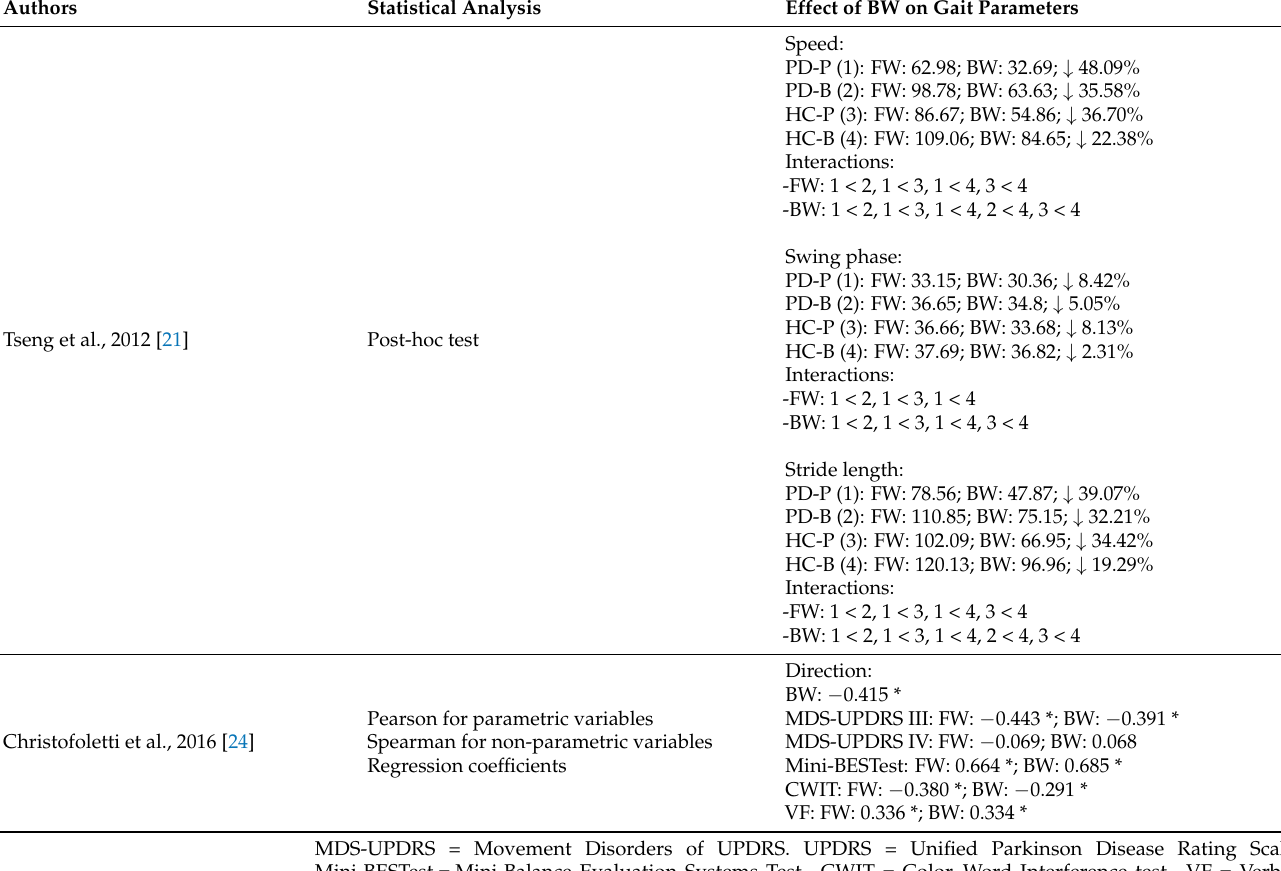
Table 2. Summary of the interaction effect between cognitive function and walking direction.